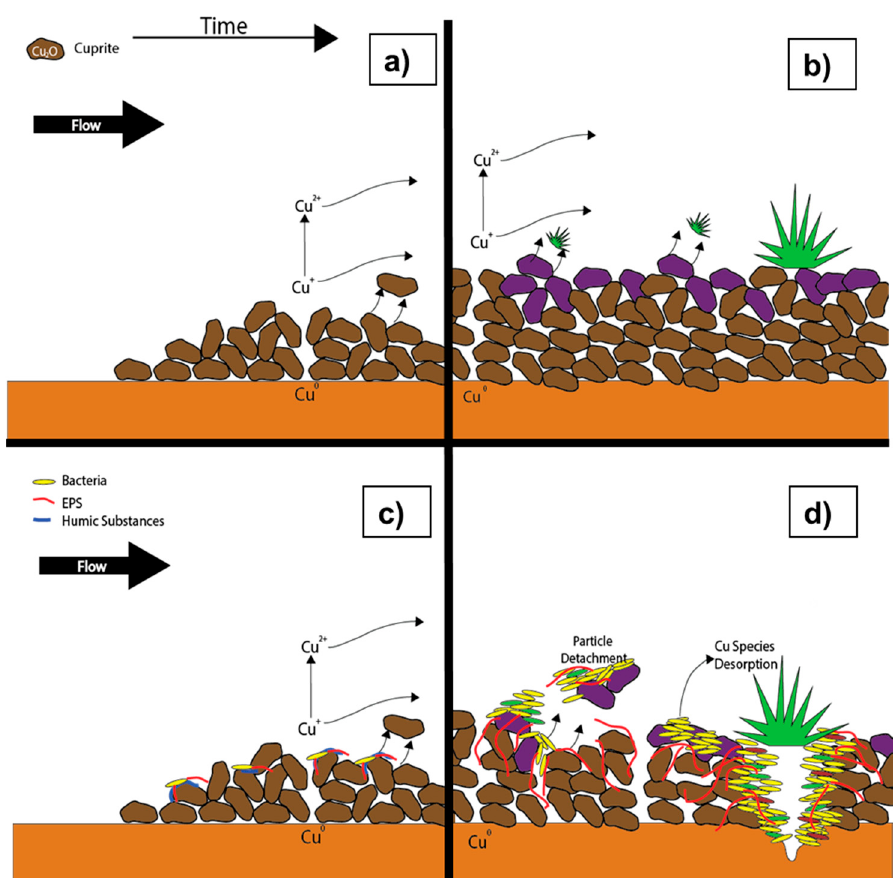
Figure 6. Conceptual corrosion model in copper pipes under flow. Abiotic conditions: ( a ) The cuprite layer growths thinner under permanent flow conditions, due to Cu(I) species flushing or shear stress; and ( b ) the flow produce the detachment of nanoparticles, probably malachite, increasing copper concentration. Biotic conditions: ( c ) Under permanent flow conditions there are more nutrients for the bacteria allowing them to grow faster; and ( d ) when the biofilm is developed, and a flow is imposed, the copper released is increased due to desorption of copper species and particle detachment.